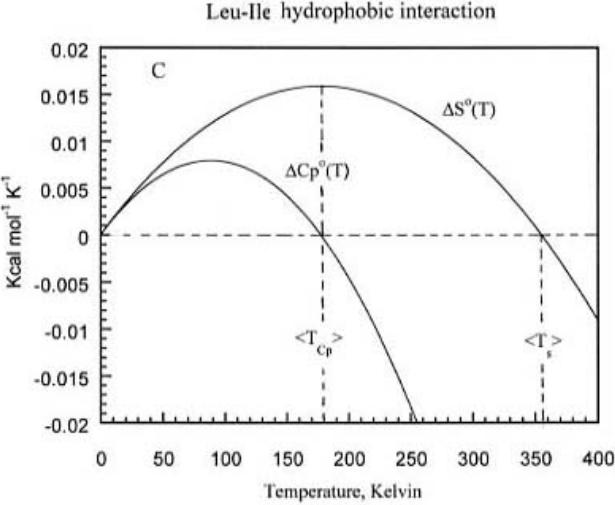
FIGURE 2C. A close-up view of a portion of Leu-Ile hydrophobic interaction as shown in Fig. 2B, over temperature range of 0– 400 K, with the magnitude of the Y-axis reduced to 0.02 to –0.02 kcal mol -1 . The thermodynamic molecular switch occurs when ∆ Cp o (T) = 0 at <T Cp > = 180 K, ∆ Cp o (T) changes sign from positive to negative, while ∆ S o (T) = 0 or T ∆ S o (T) changes from positive to negative at <T s > = 355 K.